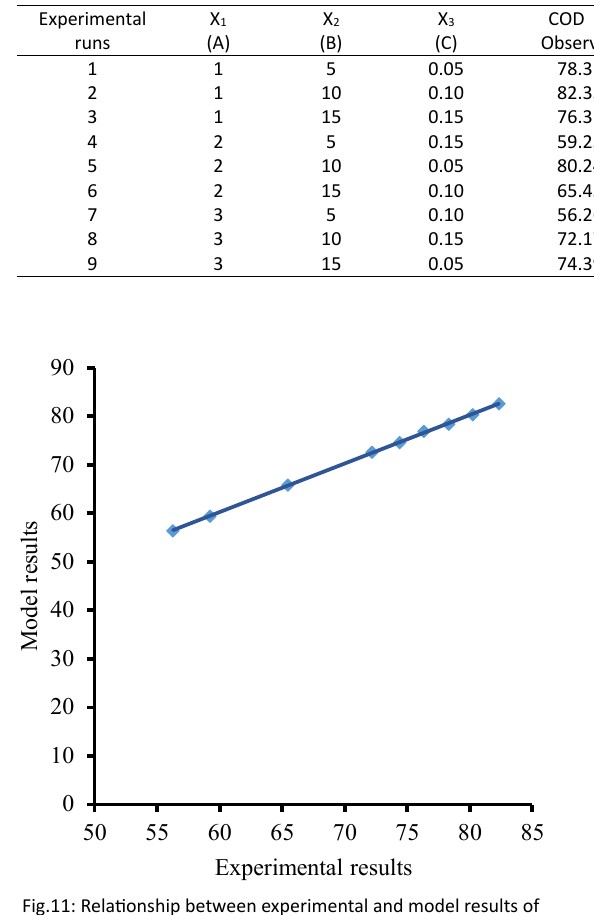
Fig.11: Relationship between experimental and model COD results of COD reduction